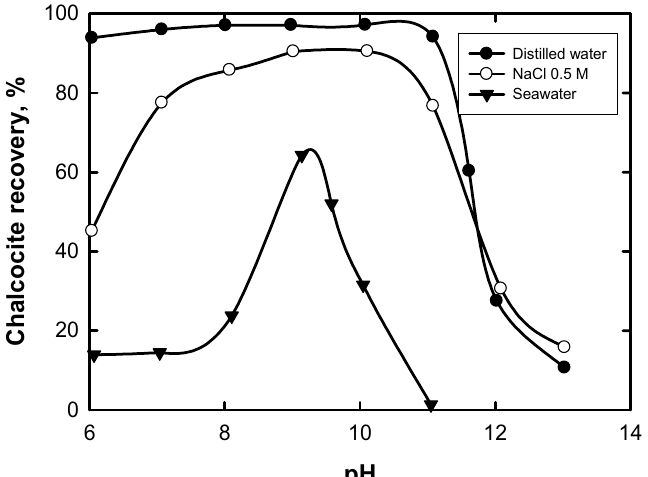
Fig. 8 Effect of pH (adjusted by NaOH/HCl) on the flotation of chalcocite in a Hallimond tube (15 mg/L IsopX and 10 mg/L amyl alcohol) (Alvarez and Castro, 1976) 17) .